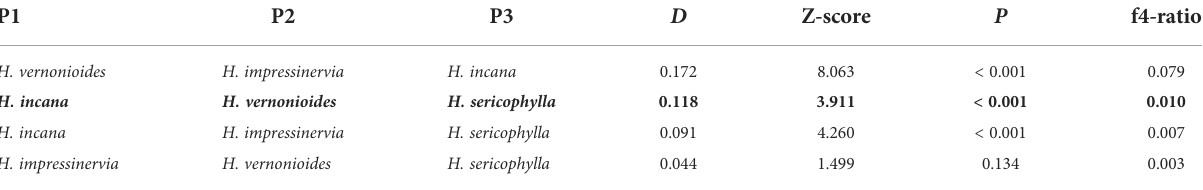
TABLE 1 ABBA-BABA statistic for the fi ve species of